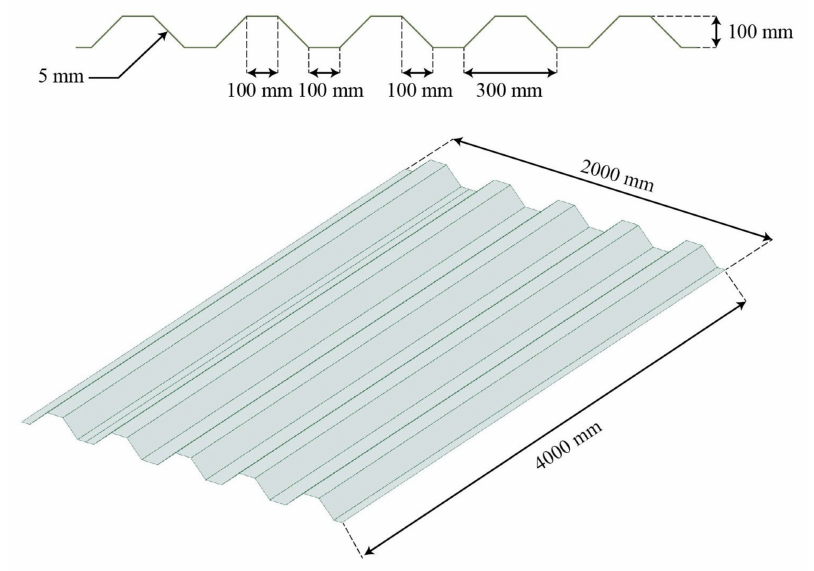
Figure 8. Geometry of the trapezoidal sheet considered in the case study.